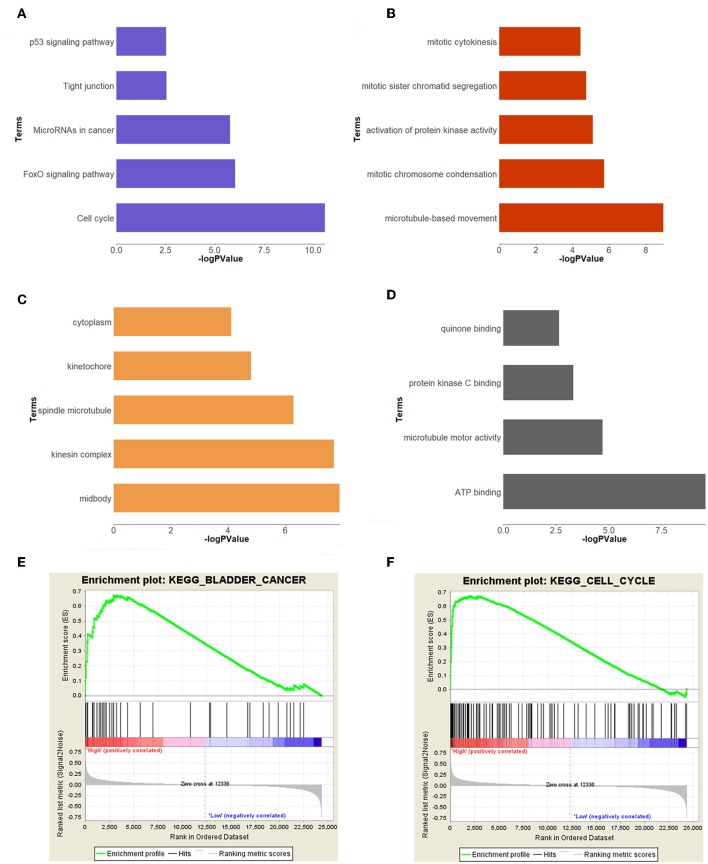
Functional annotation and GSEA analysis for brown module. (A) The signaling pathways, (B) biological process, (C) cellular components, (D) molecular composition of the brown module. (E,F) GSEA analysis revealed that the genes of brown module were mainly enriched in bladder cancer and cell cycle related pathways.